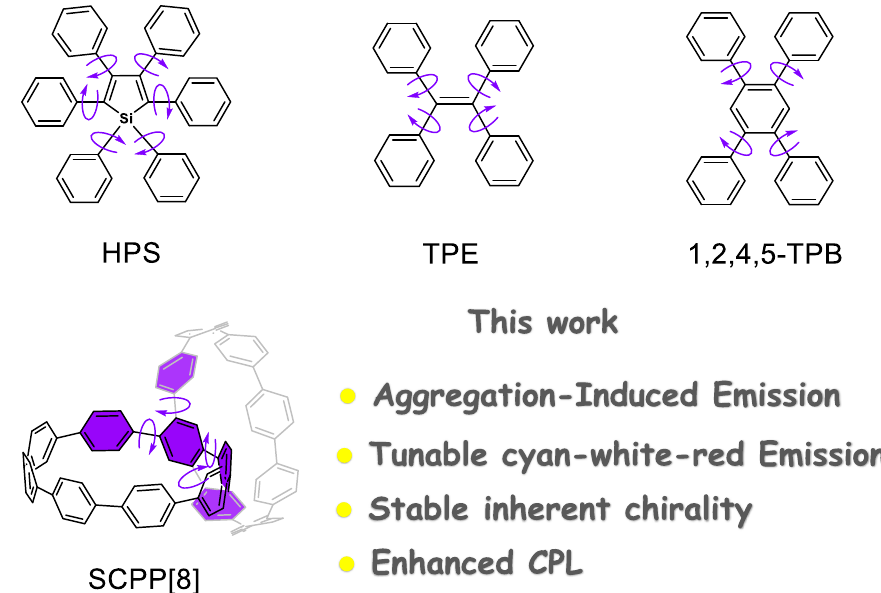
Fig. 1 Schematic representation. Top: Typical examples of structural motifs of AIEgens. Bottom: Structure of SCPP[8]